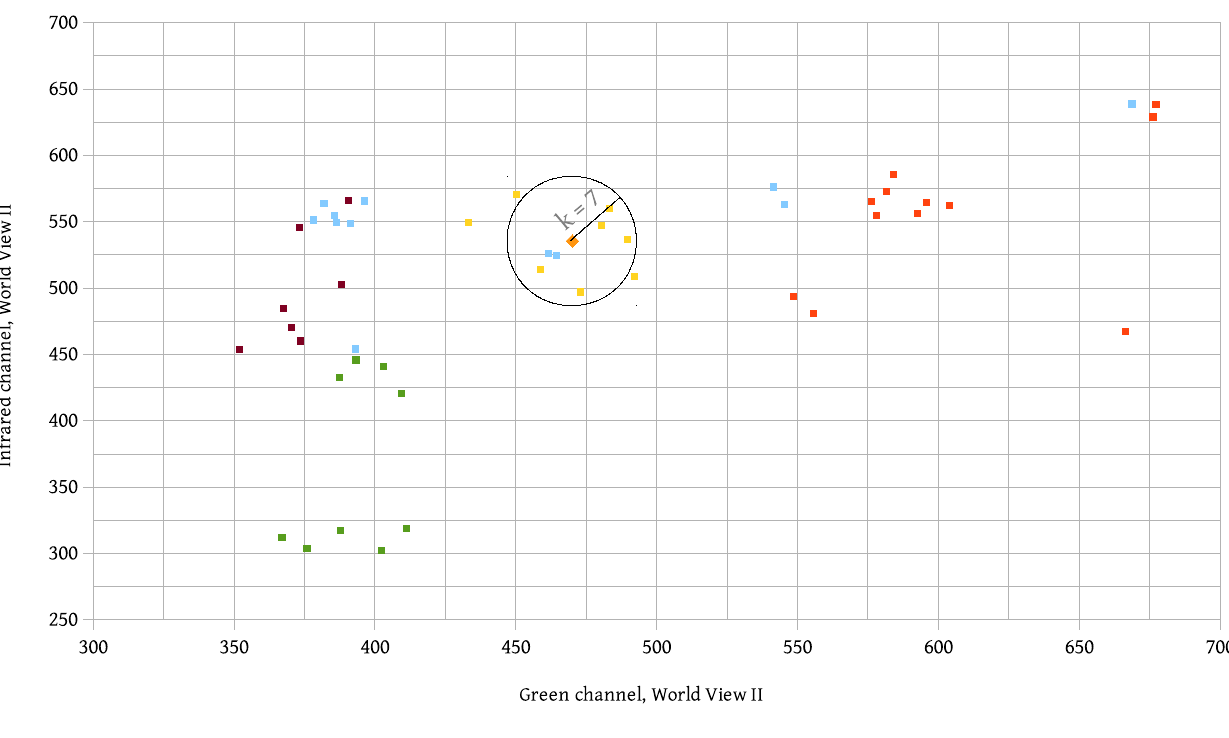
Figure 3. The fragmented feature space for 50 samples and five classes, using infra-red and green channels. The sample with an unknown class is submitted to the k nearest neighbors (kNN) algorithm with k = 7